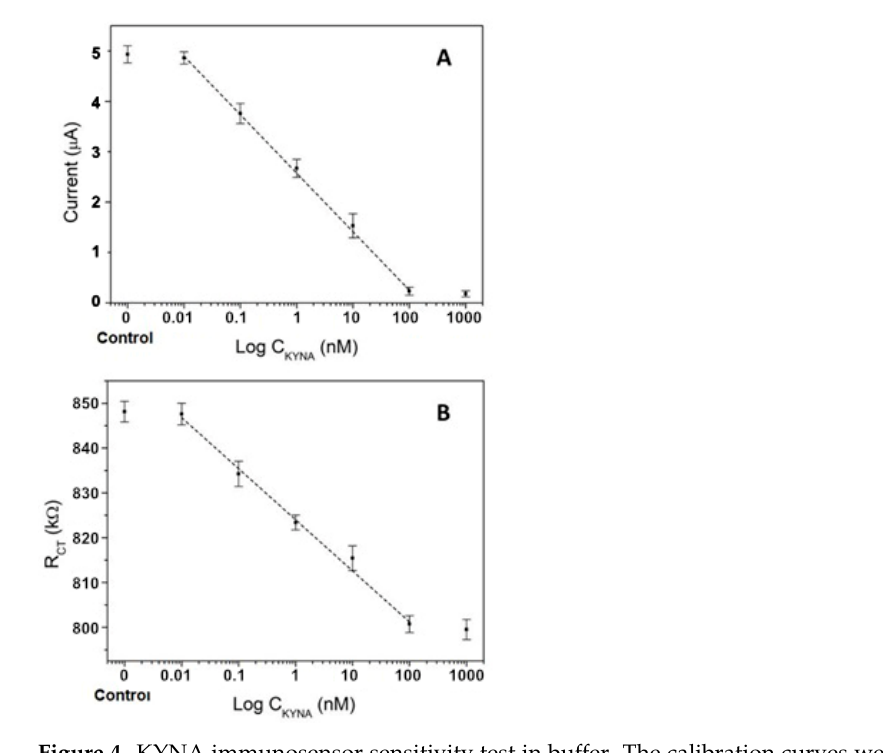
Figure 4. KYNA immunosensor sensitivity test in buffer. The calibration curves were performed with CA ( A ) and EIS ( B ). The concentrations considered were 0, 10 pM, 100 pM 1 nM, 10 nM, 100 nM, and 1000 nM ( n = 5).